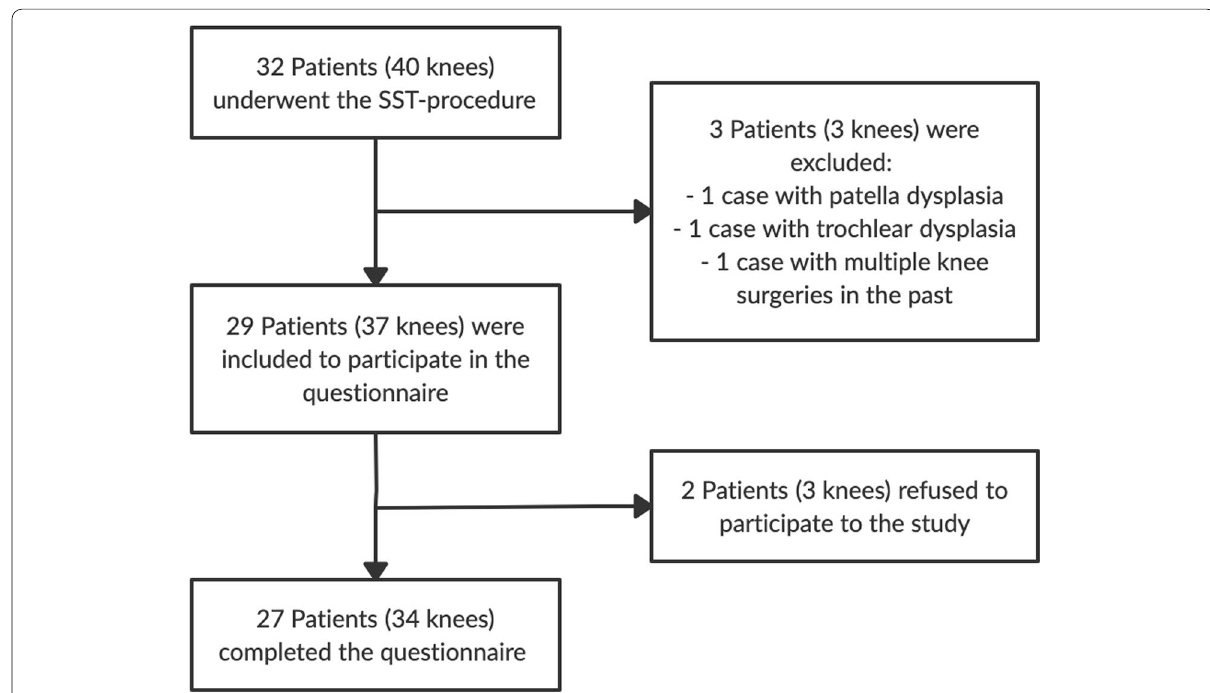
Fig. 2 Flowchart of included